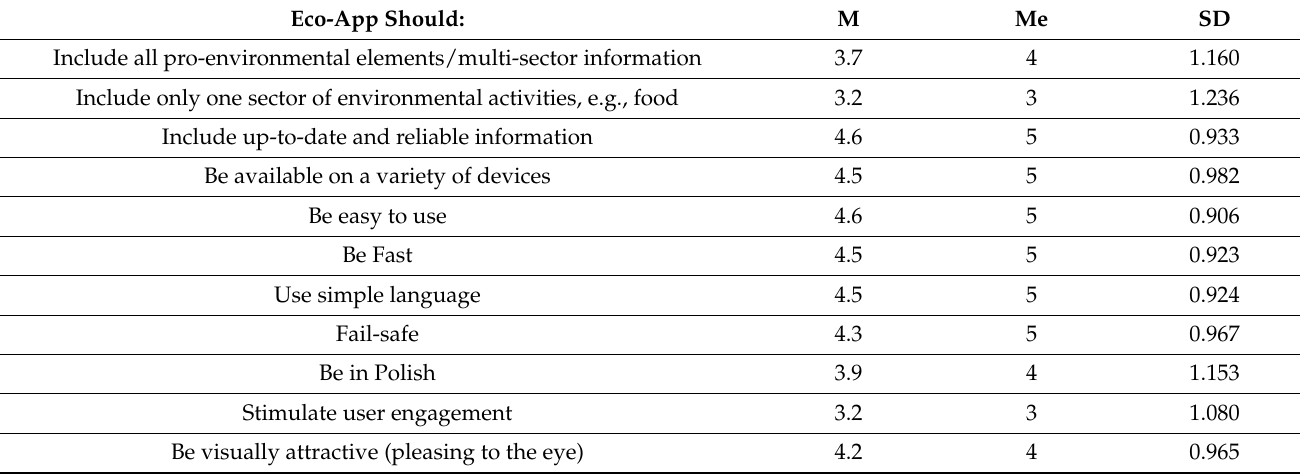
Table 7. Expected features of an optimal eco-app design rated on a five-point Likert scale ( n = 772). Eco-App Should: M Me SD Include all pro-environmental elements/multi-sector information 3.7